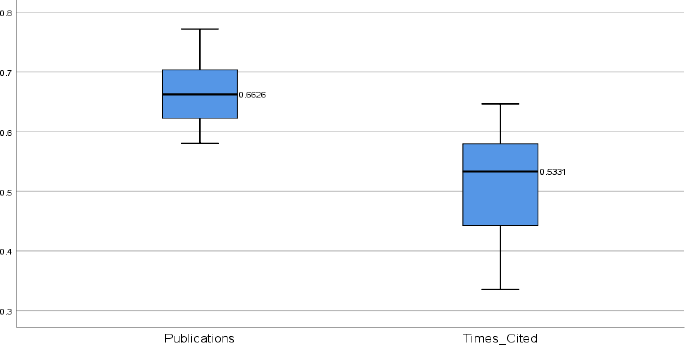
Figure 11. Distribution of correlations based on 15 criteria applied to 169 countries, their publica- tions, and citations, as a CSP map. and citations, as a CSP